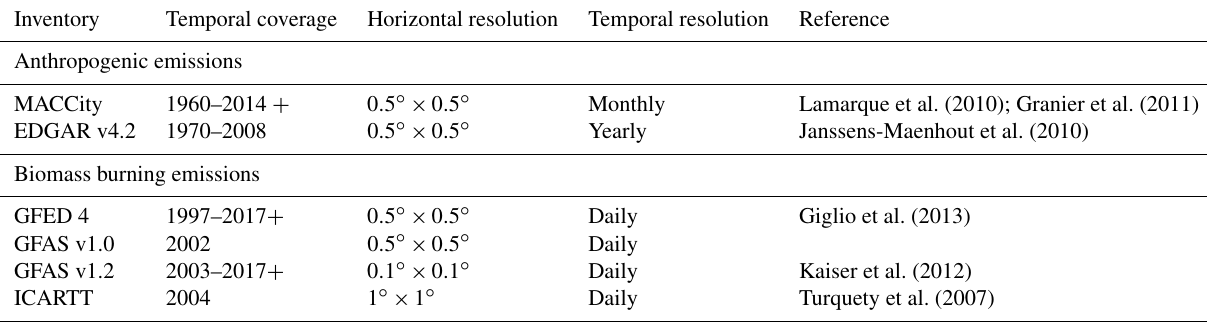
Table 2. List of emission inventories used in this study.